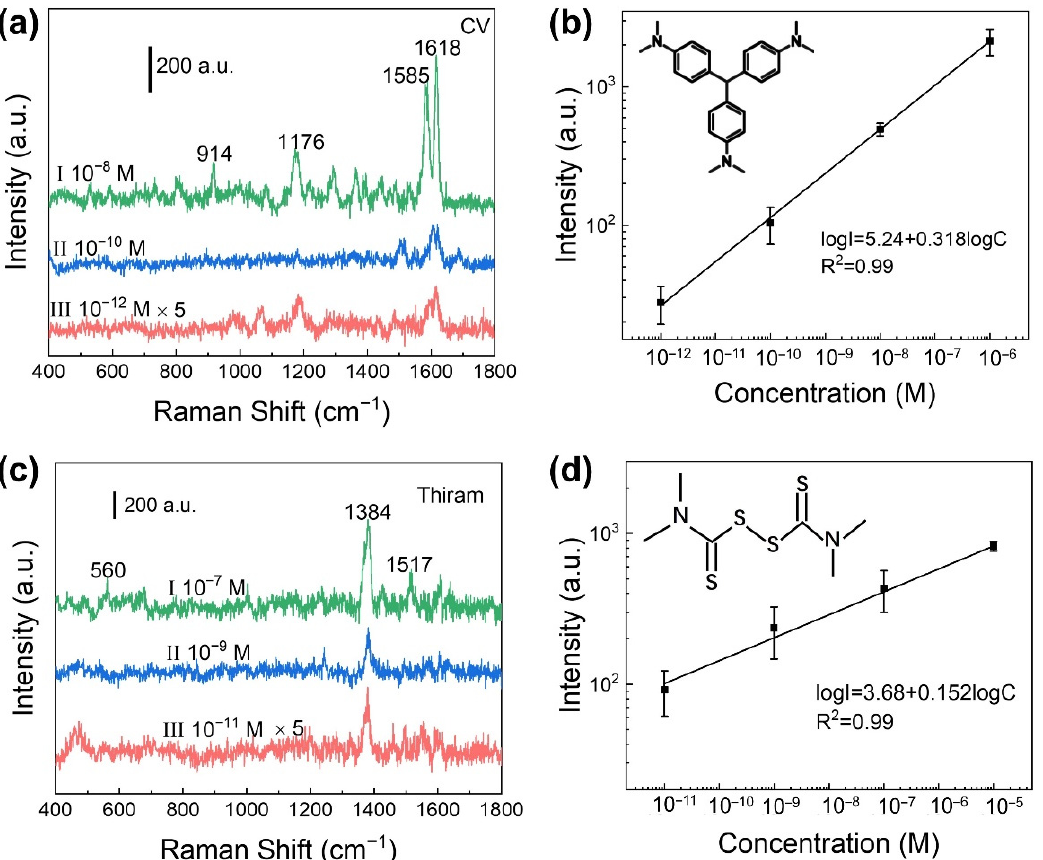
Figure 4. ( a ) SERS spectra of (Curve I) 10 − 8 , (Curve II) 10 − 10 and (Curve III) 10 − 12 M CV collected from nanoporous Ag-decorated Ag 7 O 8 NO 3 micro-pyramids. ( b ) Linear relationship between the logarithmic intensities (1618 cm − 1 peak) and the concentrations of CV. ( c ) SERS spectra of (Curve I) 10 − 7 , (Curve II) 10 − 9 and (Curve III) 10 − 11 M thiram from nanoporous Ag-decorated Ag 7 O 8 NO 3 micro-pyramids. ( d ) Linear relationship between the logarithmic intensities (1384 cm − 1 peak) and the concentrations of thiram.